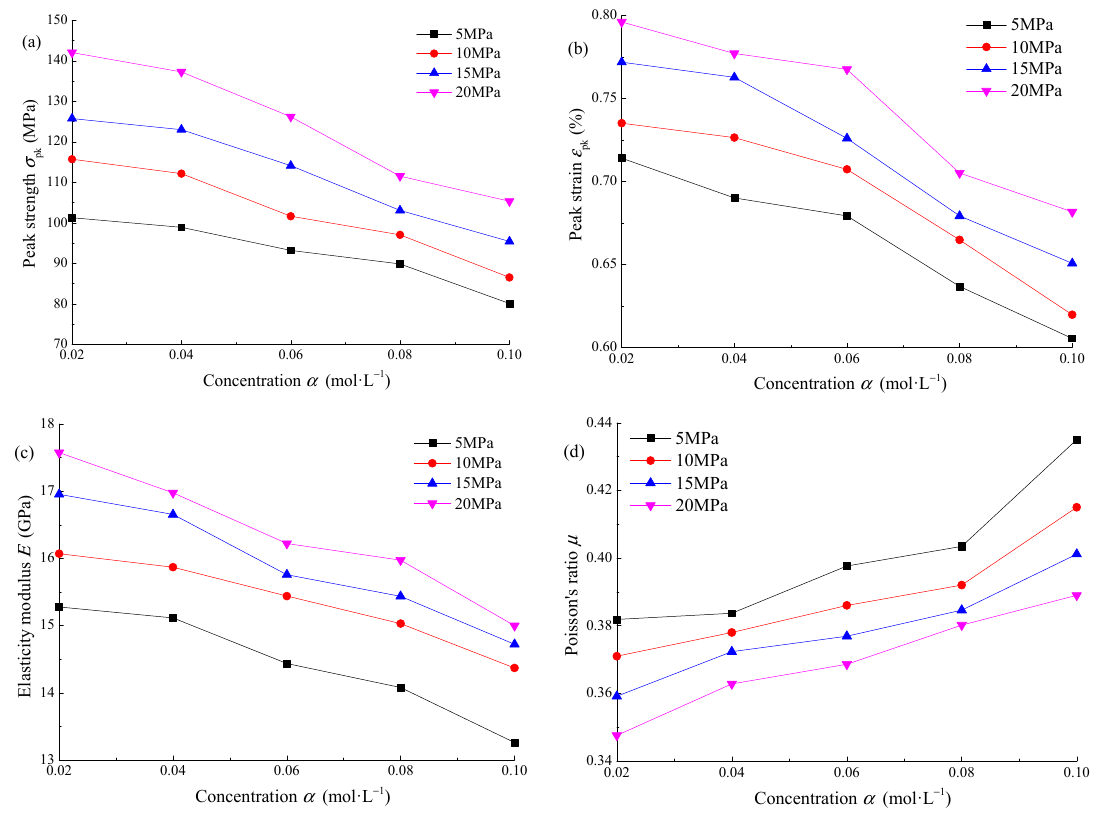
Figure 5. Distribution curve of mechanical parameters with concentration α of Na 2 SO 4 : ( a ) peak strength σ pk ; ( b ) peak strain ε pk ; ( c ) elasticity modulus E ; ( d ) Poisson’s ratio µ .